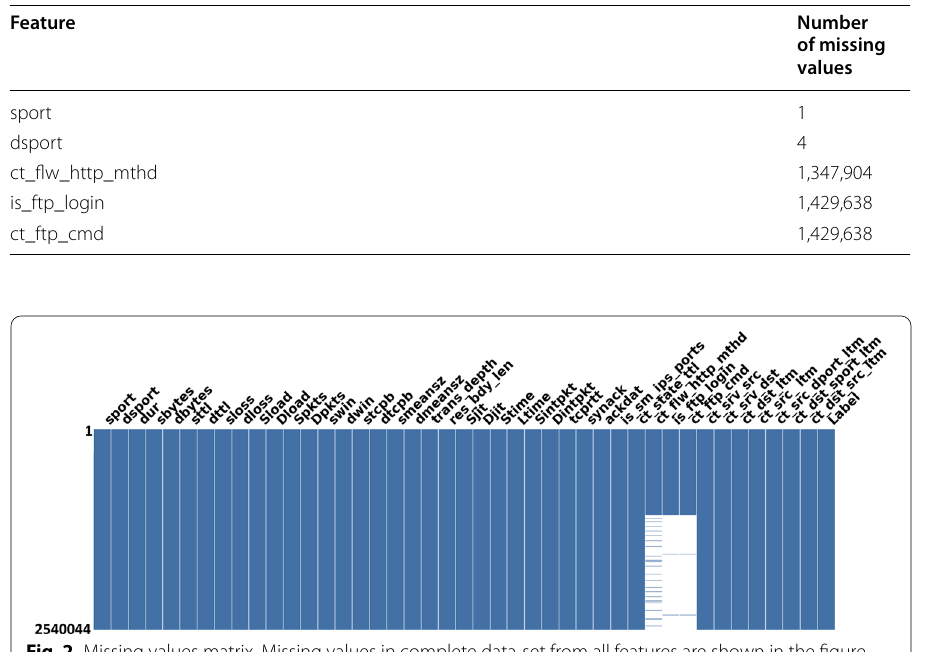
Table 4 Features with number of missing values